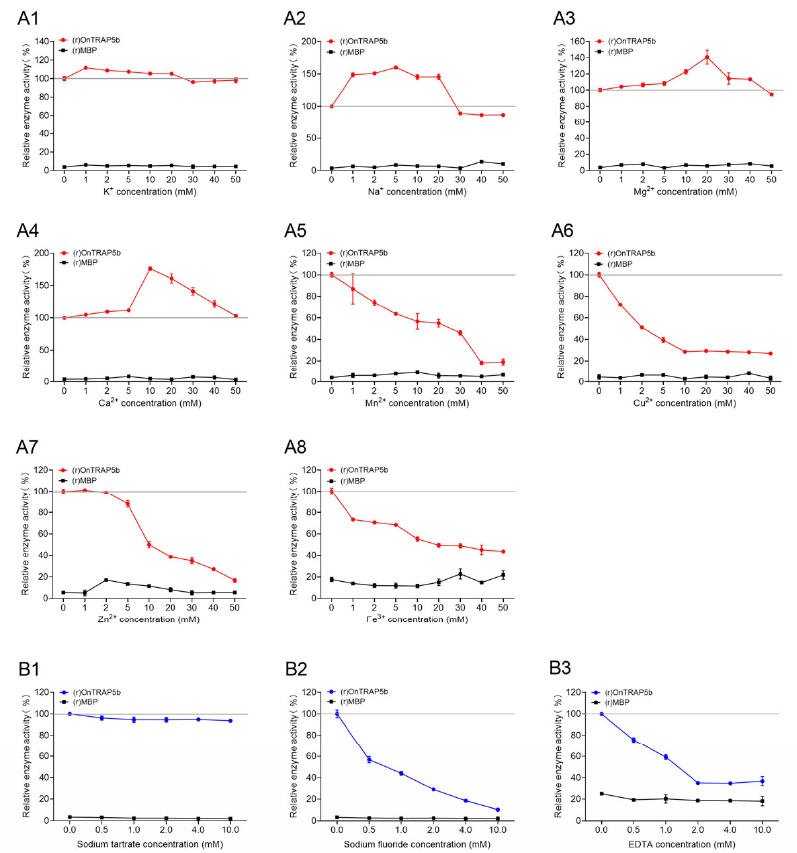
Figure 6. Effects of different metal ions and different inhibitors on (r)OnTRAP5b. The enzyme activities of (r)OnTRAP5b under different metal ions ( A1 – A8 ) and different inhibitors ( B1 – B3 ) were expressed as percentages of the relative phosphatase activity. Data are presented as means ± SD ( n = 3). n , the number of times the experiments were